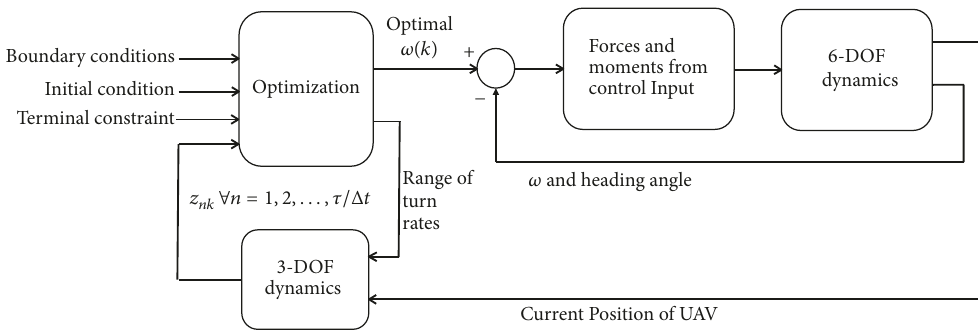
Figure 8: Summary of path planning